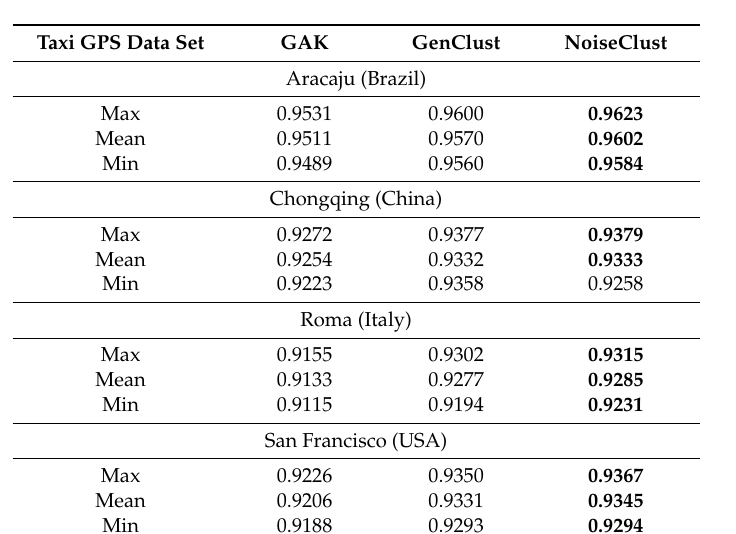
Table 2. The maximum, mean, and minimum values of silhouette coefficient ( SC ) obtained by the